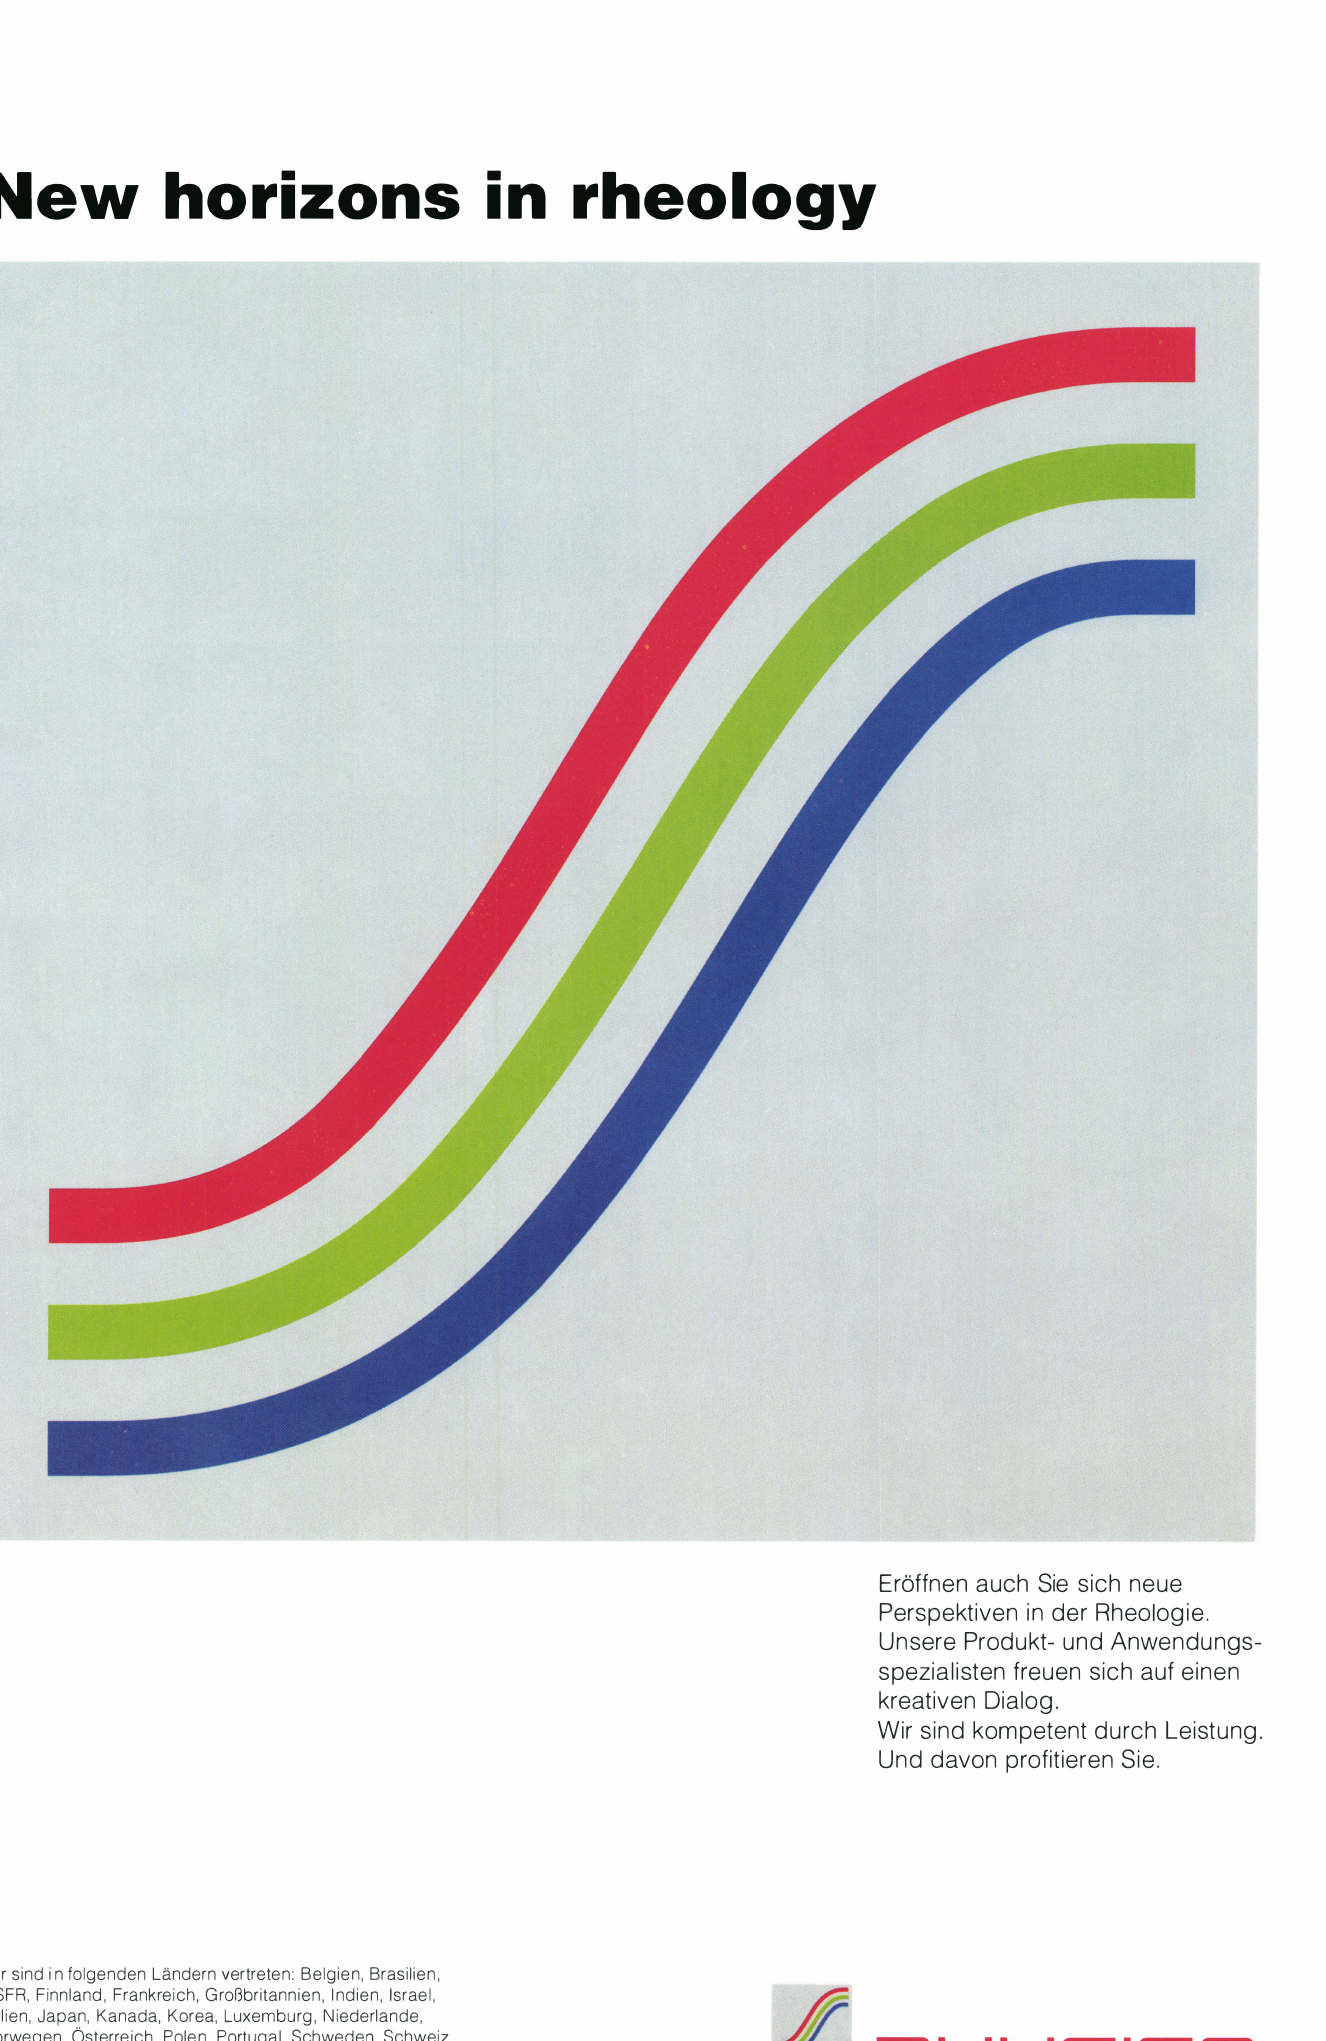
Erbffnen auch Sie sich neue Perspektiven in der